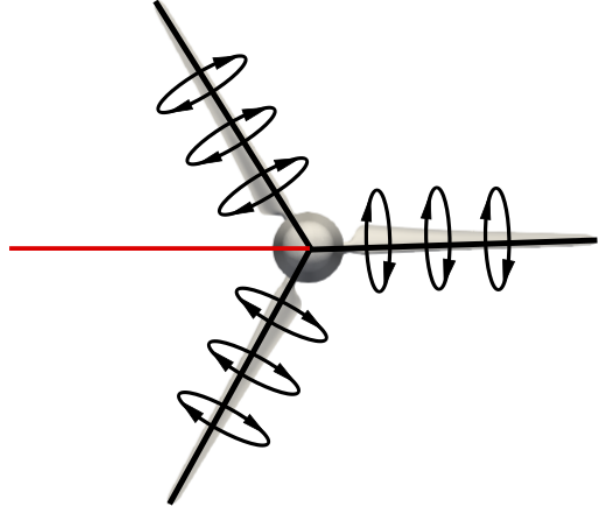
Figure 1. Schematic representation of the probing location (red line) of the new method for computing the wake induction and the AoA on a rotor operating under axial, uniform inflow. The bound circulation is represented around the blades. Along the red line, the downwash of the blade located at the 11 o’clock position is can- celled out by the upwash of the blade located at the 6 o’clock po- sition. The blade located at the 3 o’clock position does not induce any velocity along the red line. As a result, the velocities obtained along the red line are free of blade induction influences.